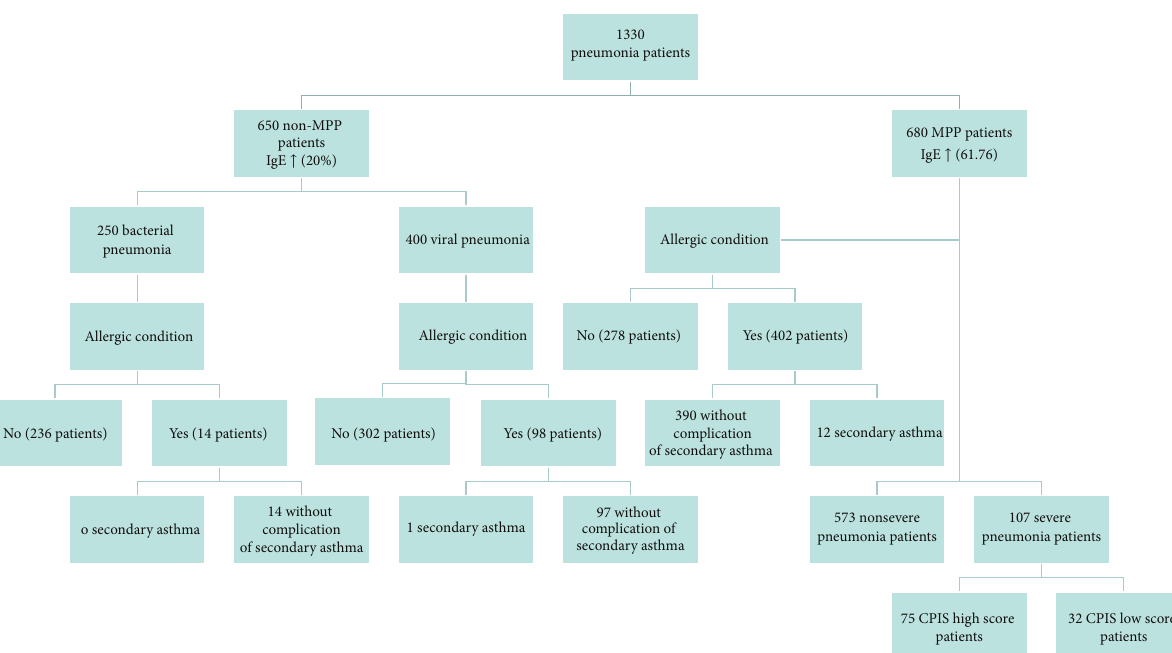
Figure 1: Characterization of pneumonia patients. The flow chart shows the categorization of the 1330 patients in this study. The 650 pneumonia patients without MP infection (non-MPP patients) tested positive for either bacterial ( 𝑛 = 250) or viral ( 𝑛 = 400) infection, and 20% had elevated IgE levels ( > 100IU/mL). Further categorization is shown for the presence of allergic conditions. Of the 680 pneumonia patients with MP infection (MPP patients), 61.76% had elevated IgE. The MPP patients could be further subdivided by the occurrence of allergic conditions ( 𝑛 = 278 without and 𝑛 = 402 with allergic conditions), including those with allergic conditions resulting in secondary asthma ( 𝑛 = 390 without and 𝑛 = 12 with secondary asthma) or they could be subdivided by the severity of the pneumonia ( 𝑛 = 573 with nonsevere pneumonia and 𝑛 = 107 with severe pneumonia), with the severe pneumonia categorized with high or low clinical pulmonary infection score (CPIS) (75 or 32 patients,